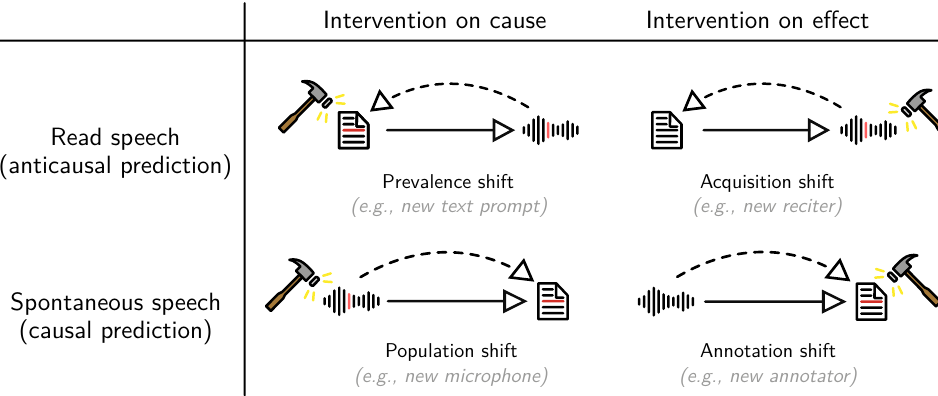
Figure 5. Classification of shifts in causal and anticausal prediction settings (solid arrows are causal mechanisms, dashed arrows are prediction directions). Upon intervention on speech signal or text, a change can propagate via the mechanism from cause to effect. Depending on the direction of prediction, shifts can have different effects on prediction and call for different measures of